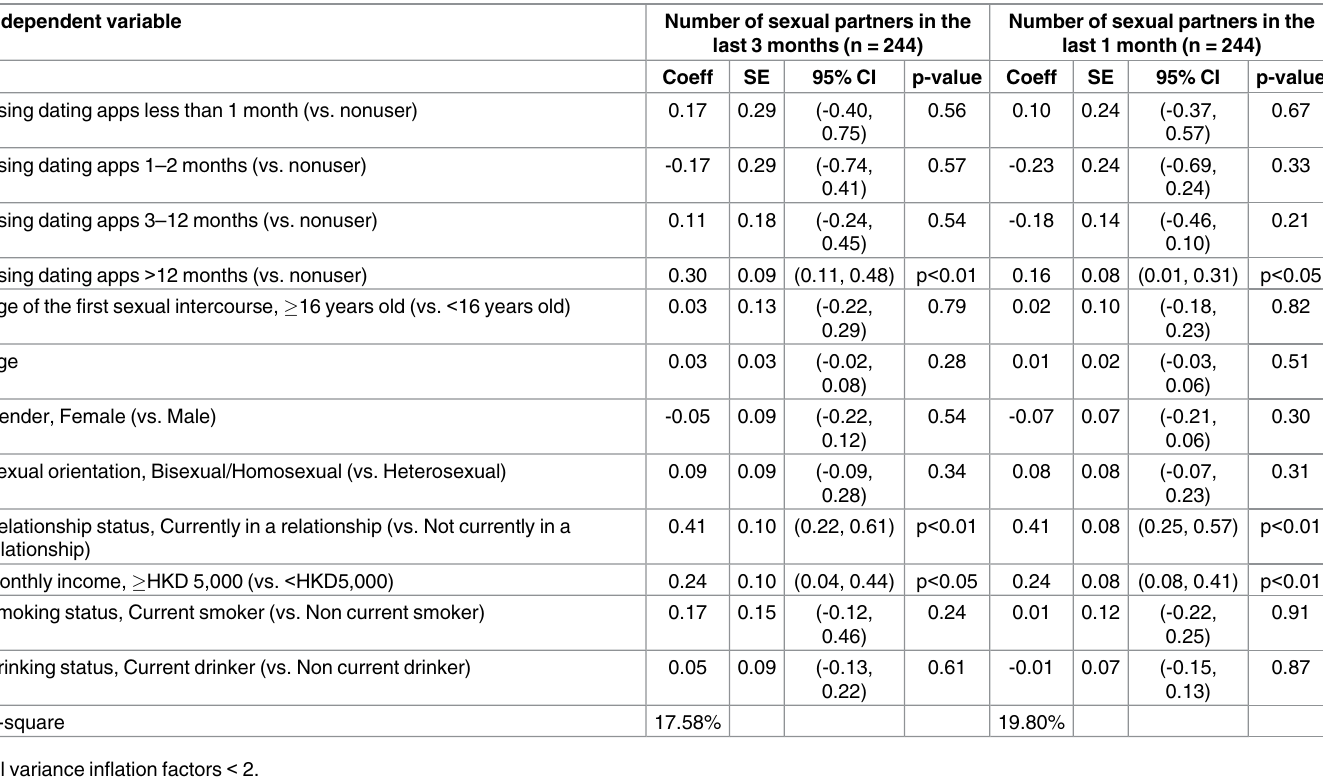
Table 5. Factors associated with the number of sexual partners by multiple linear regressions (length of time using dating